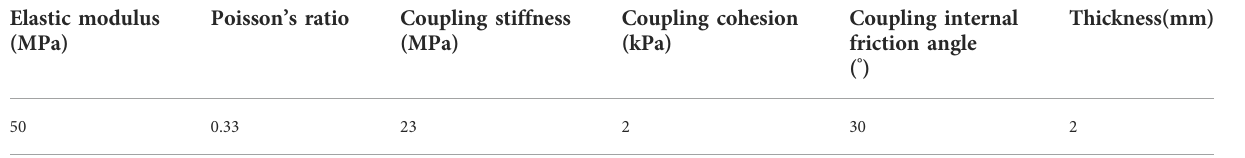
TABLE 2 Geogrid and geogrid-soil interface